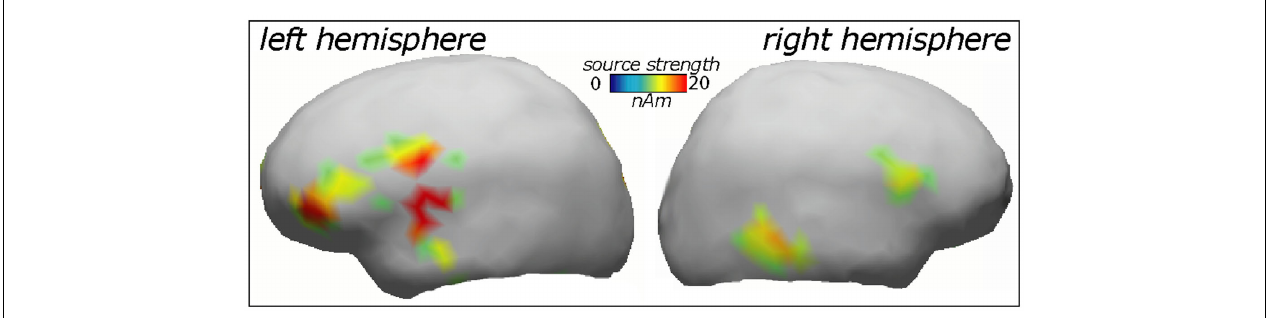
FIGURE 5 | Cortical source distributions (L2 minimum-norm) in the left and right cerebral hemisphere accounting for the increase in novel word form activation over the exposure session.